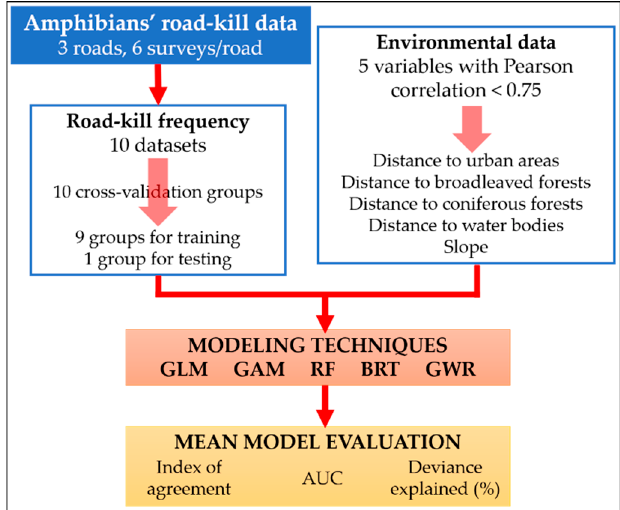
Figure 1. Main steps of the research process for comparing the performance of five regression techniques in modeling amphibian road-kills. GLM: generalized linear models; GAM: generalized additive models; RF: random forest; BRT: boosted regression trees; GWR: geographically weighted regression; AUC: area under the curve.